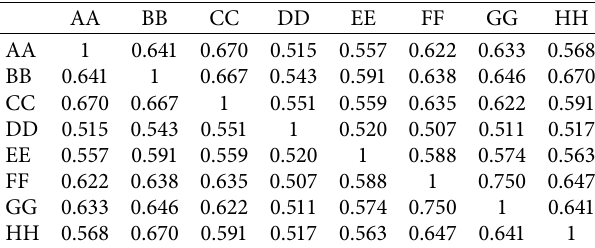
Table 7: Social network relevance of professional